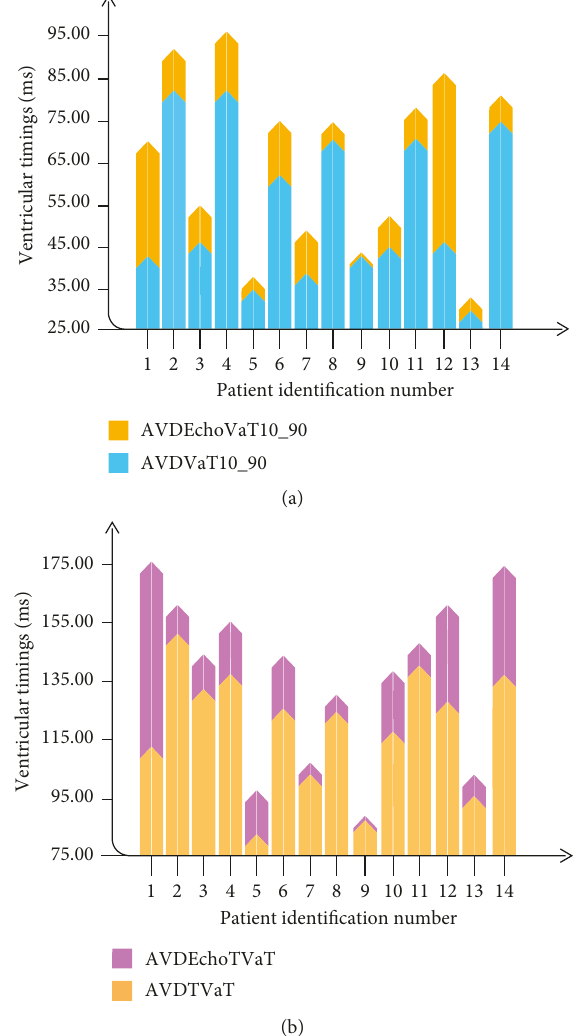
Figure 3: Activation timings for the optimal AVD obtained by the iterative method versus the shortest ventricular activations ob- tained for each patient. AVD, atrioventricular delay; AVDE- choTVaT, TVaT obtained based on the optimal AVD obtained through echocardiographic methods; AVDEchoVaT10-90, VaT 10- 90 index obtained based on the optimal AVD obtained through echocardiographic methods; AVDVaT10-90, shortest VaT 10-90 index obtained for the AVD tested; AVDTVaT, shortest TVaT obtained for the AVD tested; XX patient identification